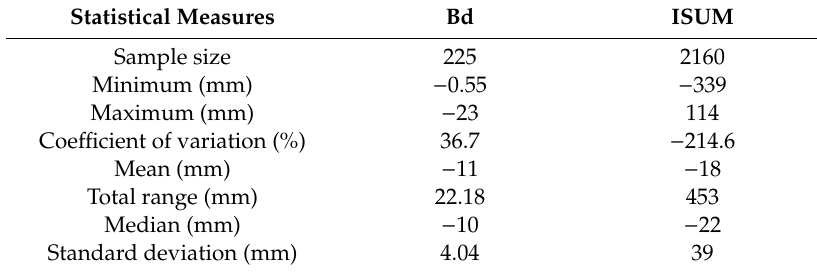
Table 2. Descriptive statistics of the database surveyed, using the ISUM and soil lowering data obtained using Bd values.